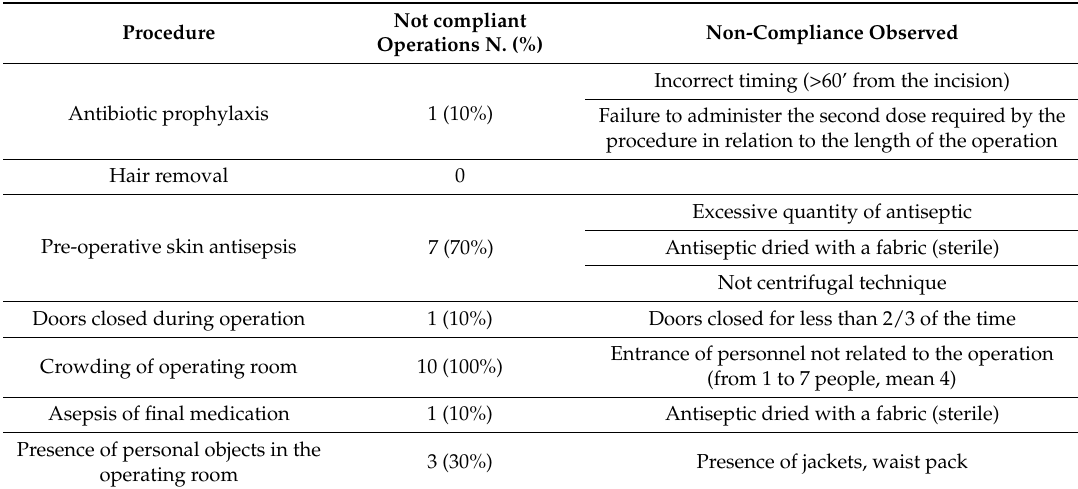
Table 4. Compliance to best practice. Observations regarding the